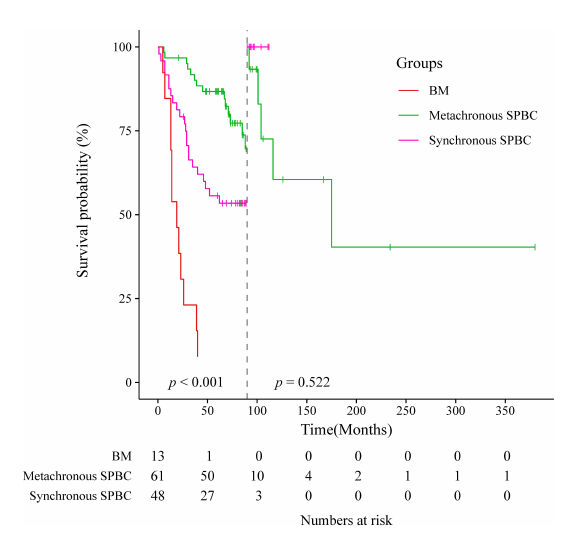
FIGURE 3.1 Landmark analysis at the 90-month landmark point of metachronous group, synchronous group and breast metastases group.